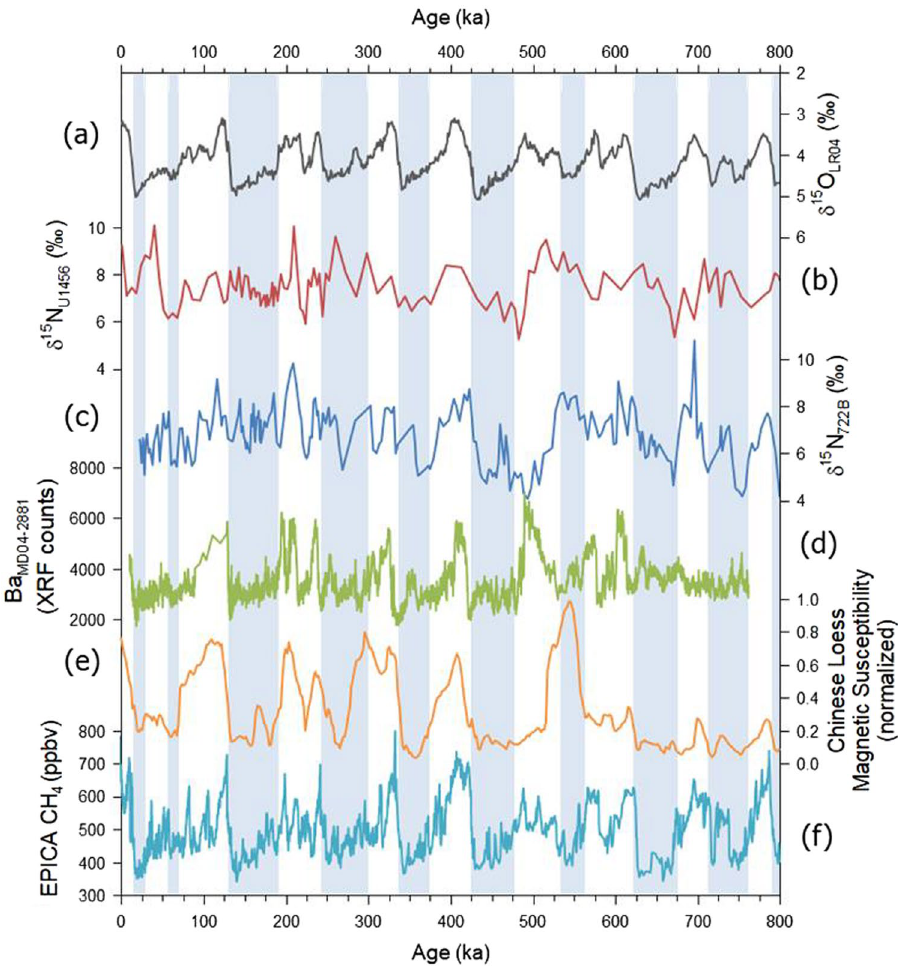
Figure 3. Orbital-scale variations in paleoclimate signals from various sites during the last 800 kyrs. ( a ) The interglacial-glacial periods defined by LR04 stacks of benthic foraminiferal δ 18 O values 36 . ( b , c ) Variation of δ 15 N values of bulk sediments at Sites U1456 (Eastern Arabian Sea) and 722B 10 (Western Arabian Sea). ( d ) Barium content by XRF counting in core MD04-2881 in the Northeastern Arabian Sea, which represents the degree of primary productivity 25 . ( e ) Magnetic susceptibility of the Chinese loess plateau indicating the strength of the East Asian Monsoon 45 . ( f ) CH 4 concentrations of the EPICA Dome C that are related to inland precipitation 47,48